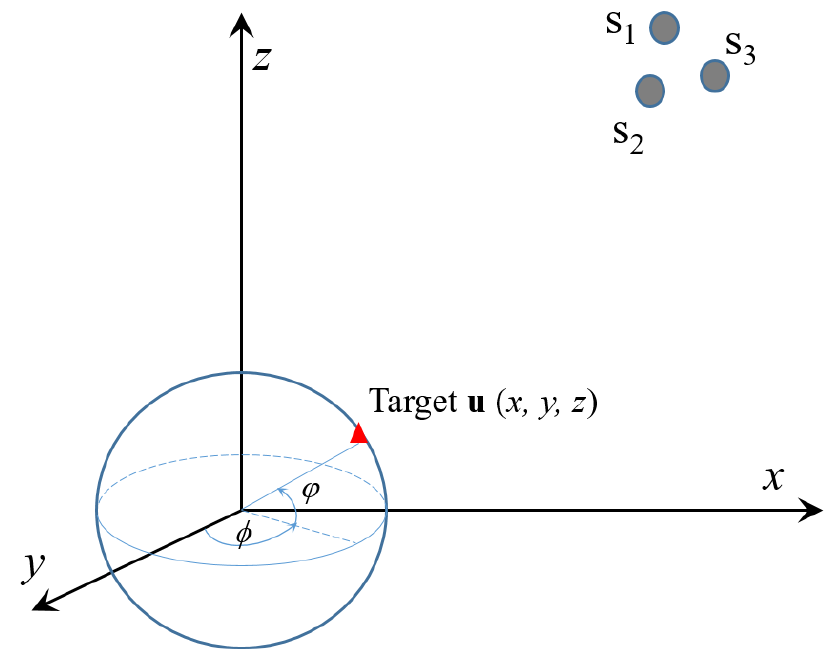
Figure 1. The coordinate system translation for the satellite-based positioning scenario.